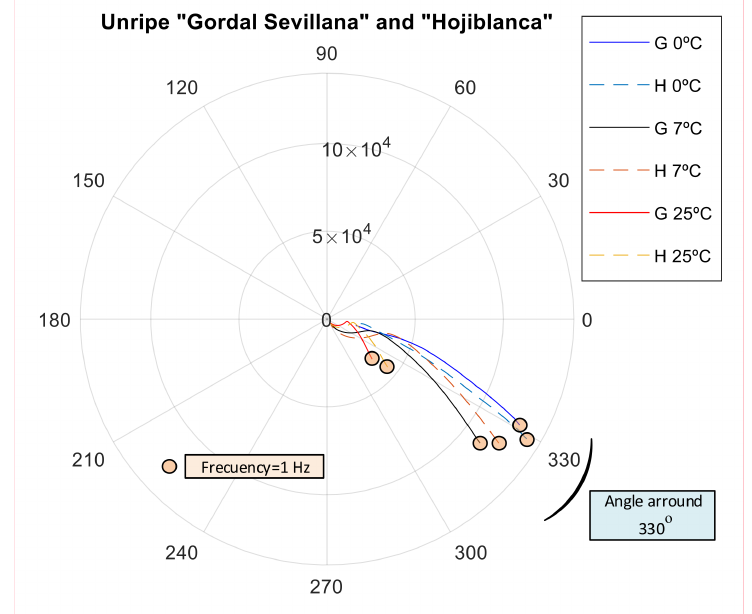
Figure 6. Frequency sweep to measure the electrical impedance of the “Gordal Sevillana” and “Hojiblanca” varieties when unripe (average values from 100